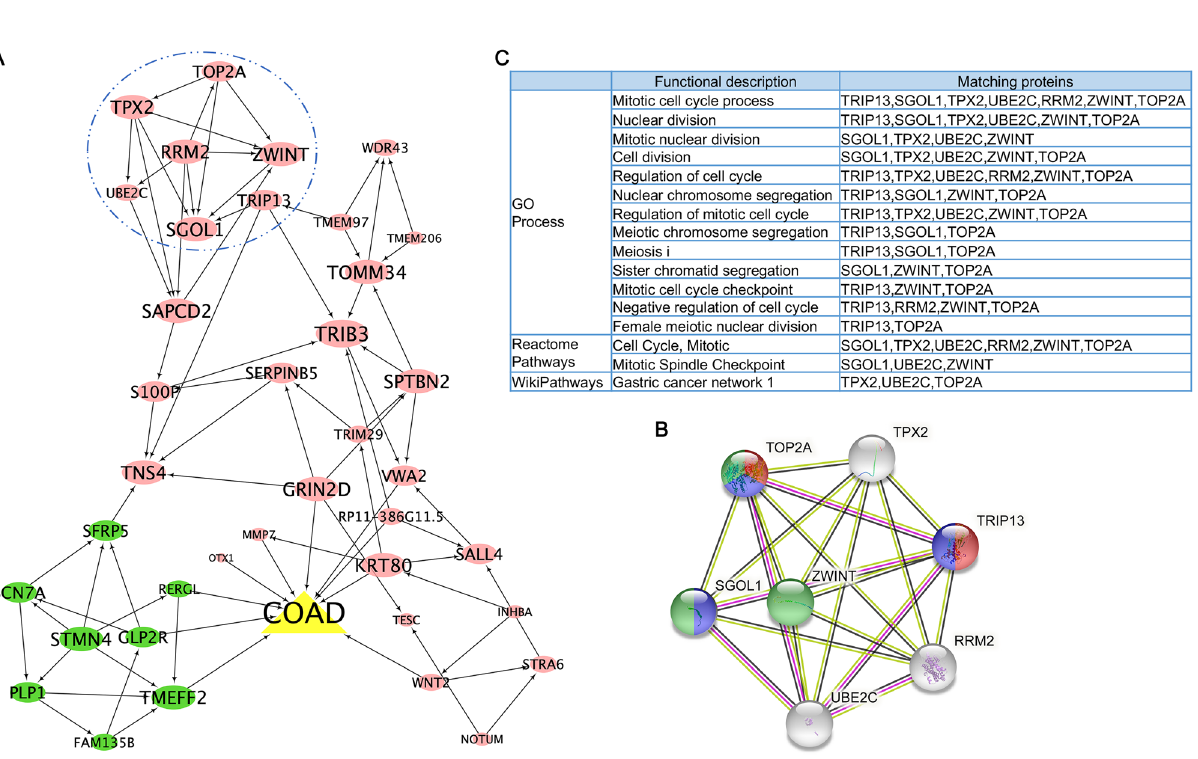
Figure 5. Bayesian network of the 38 candidate genes as well as the PPI network analysis. ( A ) Bayesian network of the 38 candidate genes. The red and green eclipses represent the up-regulated and down-regulated DEGs in COAD tumors, respectively. ( B ) PPI network of the seven up-DEGs [the seven genes in circle of ( A ] from STRING functional database. ( C ) Functional annotation of the genes in the PPI